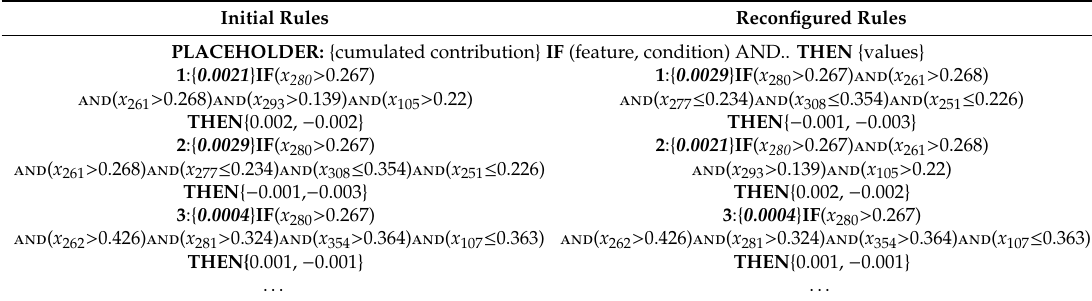
Table 1. An example of a rule set reconfiguration with the proposed rule distillation. Initial Rules Reconfigured Rules